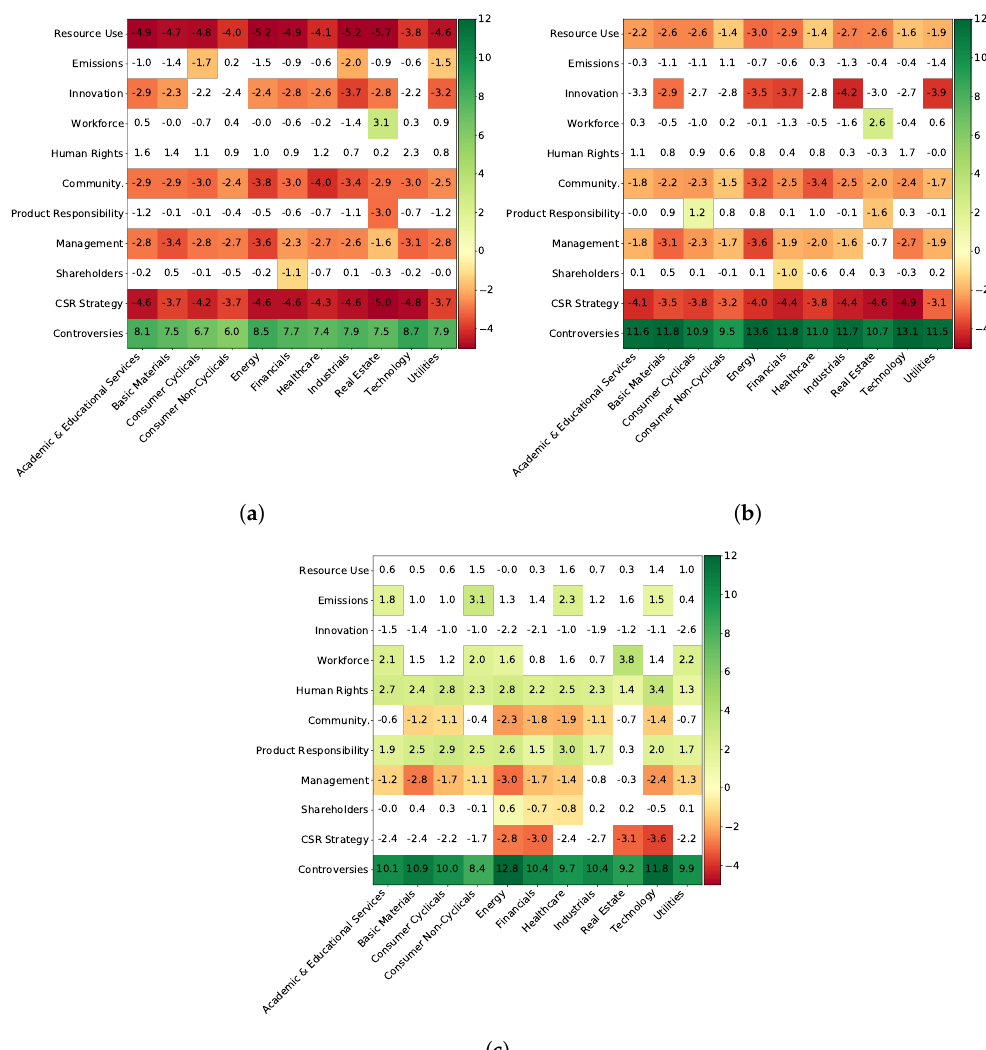
Figure 14. Materiality matrices: marginal effects of the combination ESG feature/Sector feature on the predicted probability of having a positive return, bucketed by market capitalization. Blank cells are those that were not found statistically significant by the Benjamini–Hochberg procedure. ( a ) Small market capitalization (<2 B € ); ( b ) Mid market capitalization (>2 B € , <10 B € ); ( c ) Large market capitalization (>10 B €